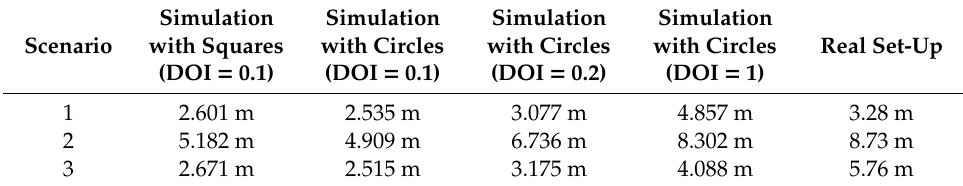
Table 2. Average